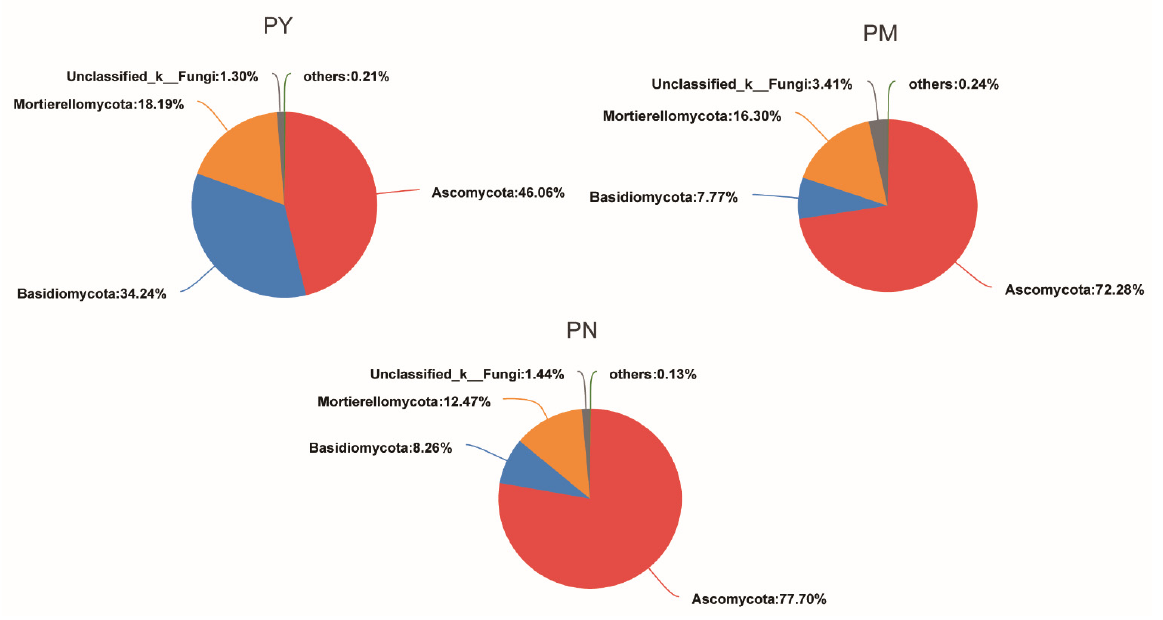
Figure 3. The composition of rhizosphere soil fungi of P. tabuliformis on phylum level at different stand ages. PY: young forest (10a), PM: middle-aged forest (20a), and PN: near-mature forest (30a).